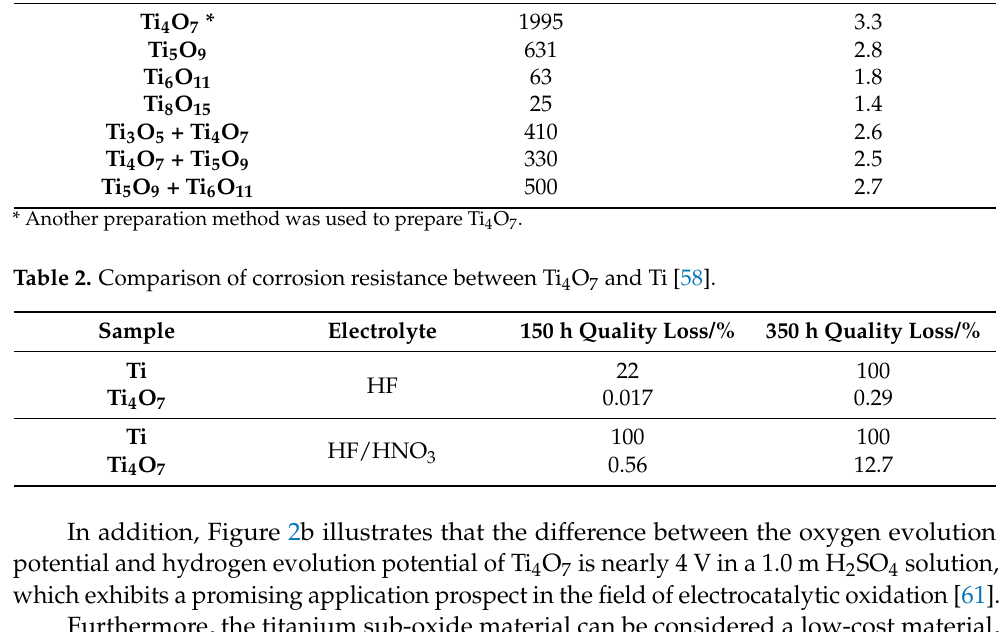
Table 1. Electrical conductivity of each phase of titanium sub-oxides at 298 K [58].